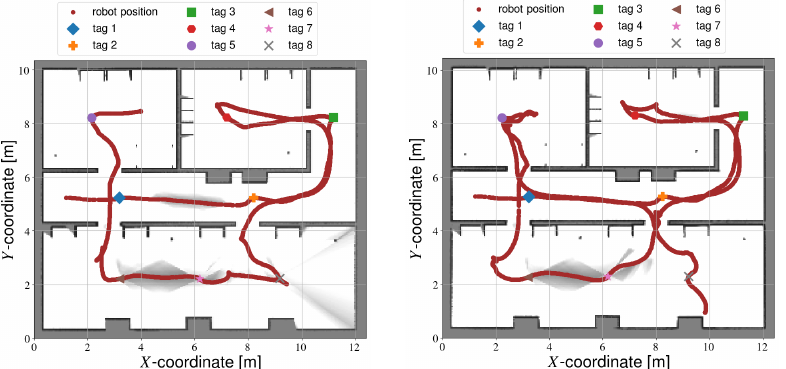
Figure 9. Calibration results from two different fully autonomous simulations. White pixels indicate free space, black pixels represent obstacles and grey areas indicate unexplored space.